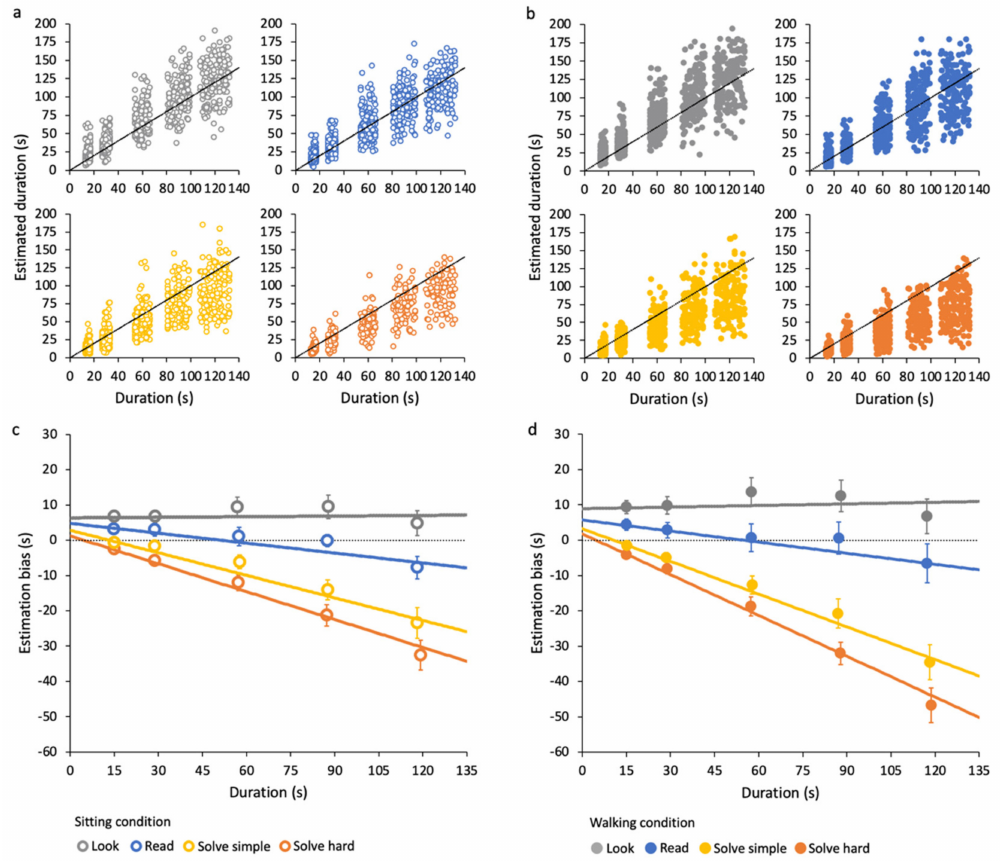
Figure 3. Time estimations during different tasks. ( a ) Sitting condition: different panels represent all data in different tasks (see different colors in the legend). ( b ) Walking condition: different panels represent all data in different tasks (see different colors in the legend). ( c ) Sitting condition: estimation bias averaged over time intervals and participants. The dashed lines represent best fits calculated on data averaged on smaller time intervals (2 s, see text). Look: intercept = 6.4 ± 0.9, slope = 0.005 ± 0.2, χ 2 (35) = 45.9. Read: intercept = 4.8 ± 0.8, slope = − 0.09 ± 0.2, χ 2 (35) = 50.1. Solve simple: intercept = 2.8 ± 0.6, slope = − 0.2 ± 0.2, χ 2 (35) = 57.8. Solve hard: intercept = 1.2 ± 0.4, slope = − 0.3 ± 0.01, χ 2 (35) = 36.1 ( d ) Walking condition: estimation bias averaged over time intervals and participants. Solid lines represent best-fit curves, calculated as in c). Look: intercept = 8.9 ± 0.8, slope = 0.01 ± 0.2, χ 2 (35) = 35.6. Read: intercept = 5.7 ± 0.8, slope = − 0.1 ± 0.2, χ 2 (35) = 41.6. Solve simple: intercept = 3.3 ± 0.6, slope = − 0.3 ± 0.2, χ 2 (35) = 40. Solve hard: intercept = 1.8 ± 0.4, slope = − 0.4 ± 0.01, χ 2 (35) = 36.7. Error bars are SE across